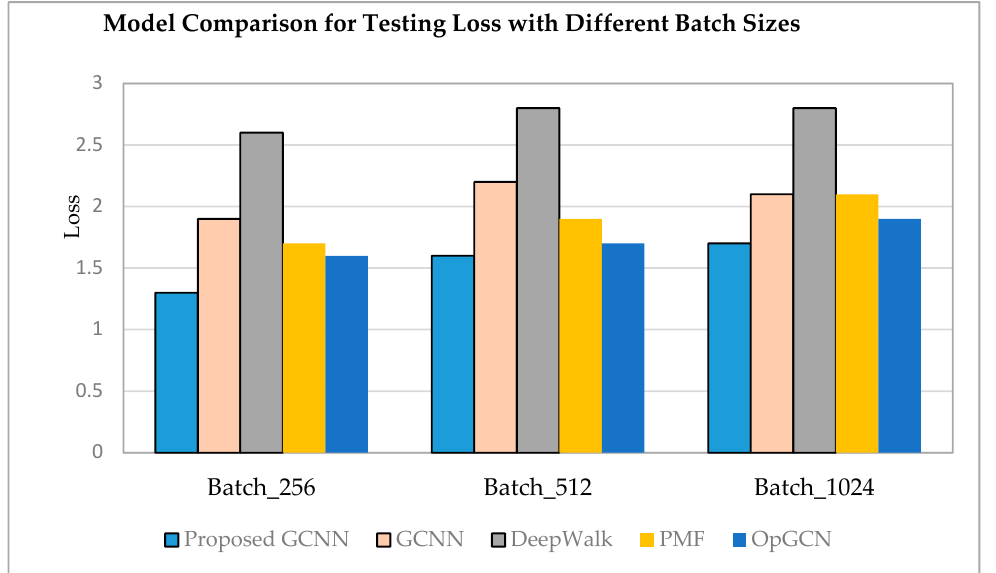
Figure 12. Testing loss with respect to different batch sizes.